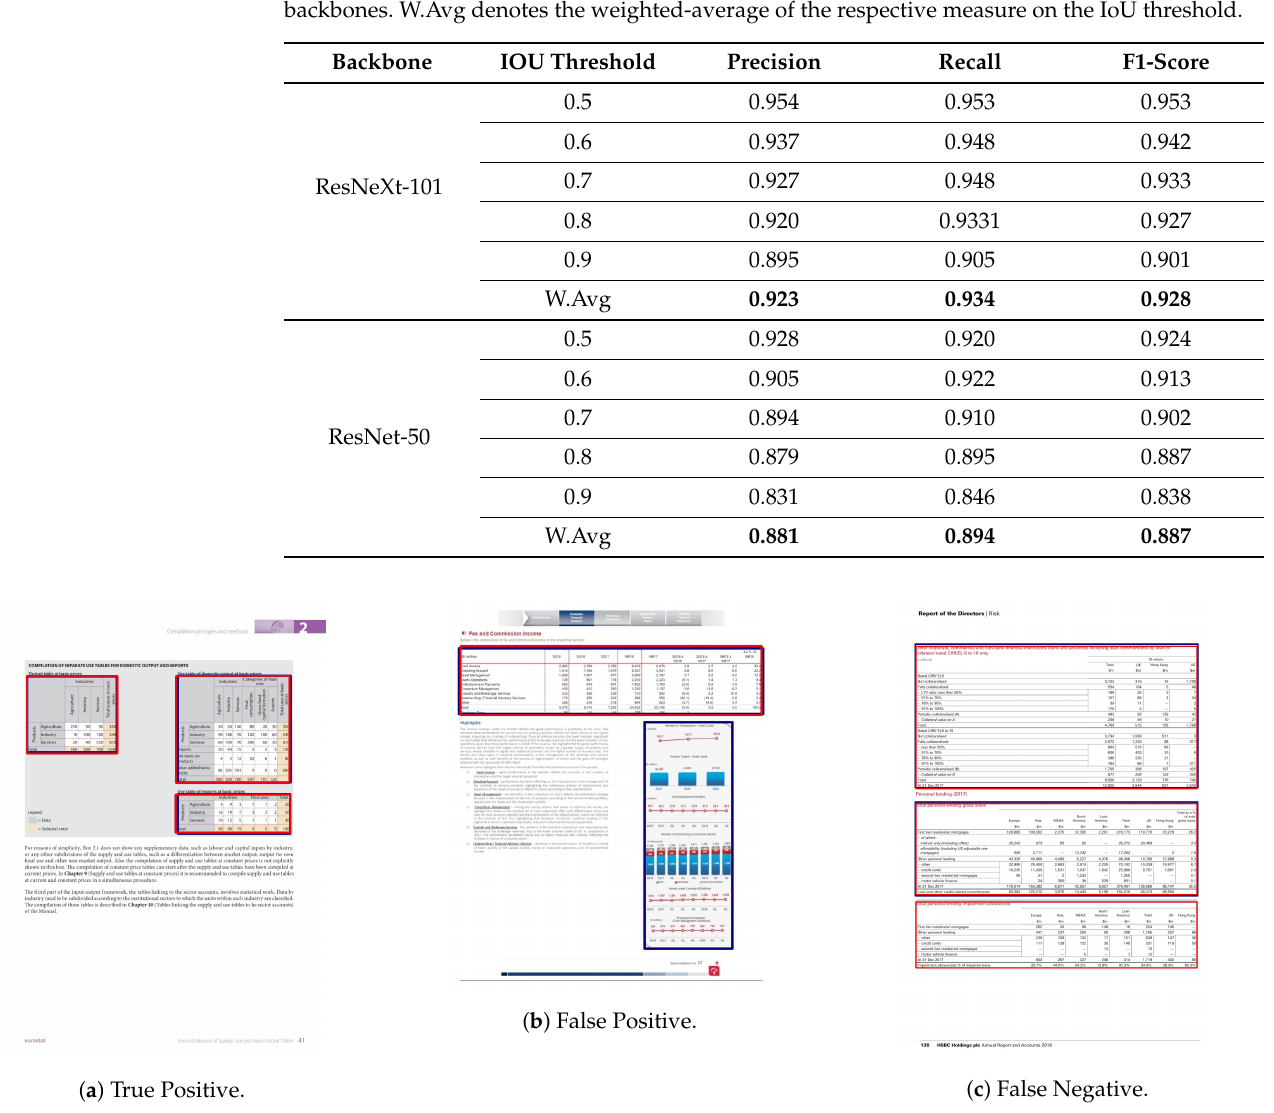
Figure 4. HybridTabNet results on ICDAR-2019 Track-A Modern dataset. ( a – c ) True positive, False positive, and False negative results, respectively. The blue outline shows the predicted table, and the red outline highlights the ground truth